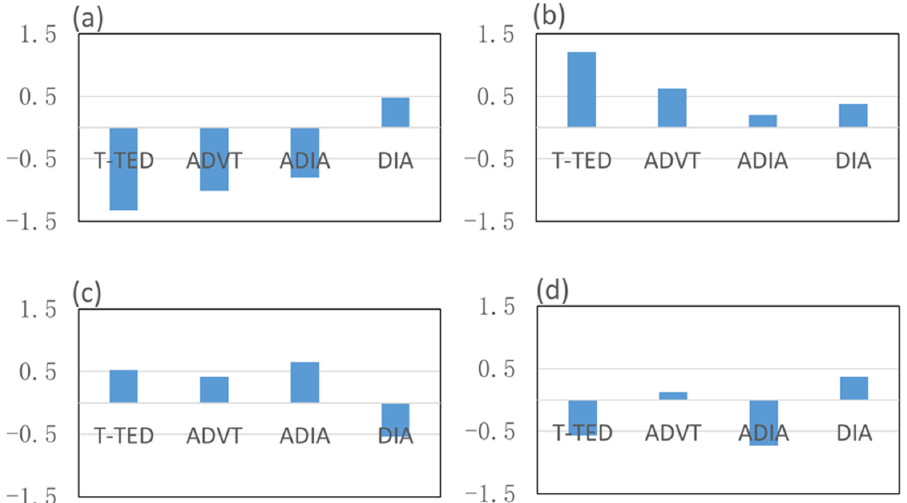
Figure 7. The 10–40-day filtered temperature tendency (T-TED), temperature advection (ADVT), adiabatic variation (ADIA), and diabatic variation (DIA) during the nine days before the peak day ( a ), and the nine days after the peak day ( b ) in the north of the jet exit region integrated from the surface to 300 hPa; ( c ) shows the nine days before the peak day in the south of the exit region; and ( d ) shows the nine days after the peak day in the south of the exit region. Unit: °C/d.